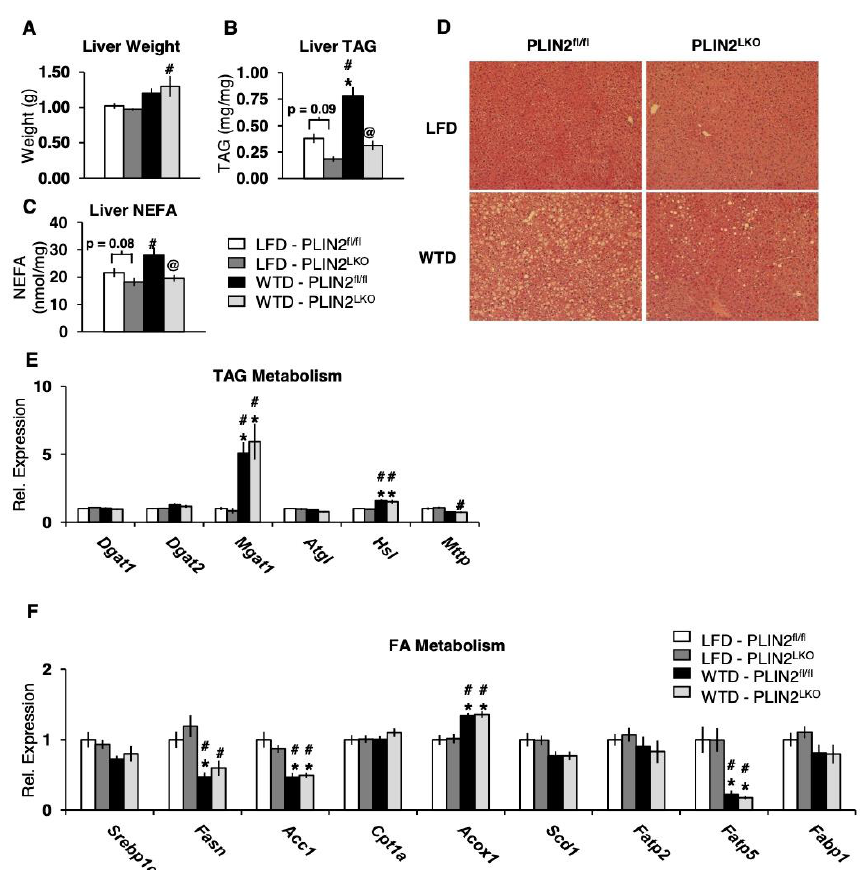
Figure 3. Ablation of hepatic PLIN2 protects mice against diet-induced hepatic steatosis in the absence of changes in lipogenic targets. ( A ) Liver weight, ( B ) liver TAG and ( C ) liver NEFA in 20-week-old mice after 12 weeks of LFD or WTD diet treatment. Liver weight n = 11–13/group. Liver TAG and NEFA, n = 6–8/grp. ( D ) Representative hematoxylin and eosin staining of liver sections harvested from 6 h fasted mice after 12 weeks of LFD or WTD treatment. ( E ) Gene expression of proteins involved in TAG metabolism and ( F ) FA metabolism in livers of 6 h fasted mice fed LFD or WTD for 12 weeks. n = 10–13/group. Data are presented as the mean ± SEM. * p ≤ 0.05 vs. LFD–PLIN2 fl/fl , # p ≤ 0.05 vs. LFD–PLIN2 LKO , and @ p ≤ 0.05